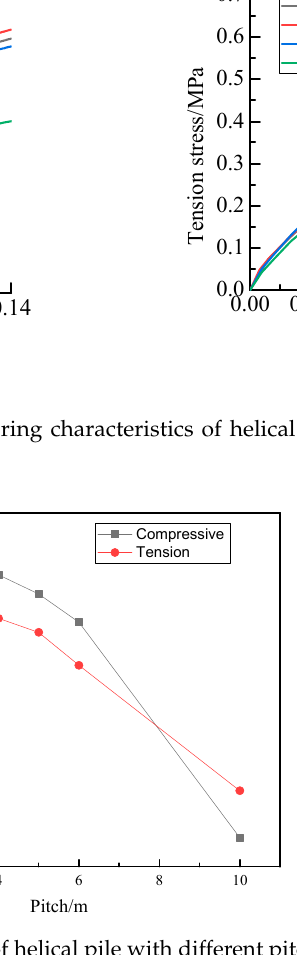
Figure 19. Uplift bearing characteristics of helical pile. ( a ) Load-displacement curves; ( b ) V/S -dis- placement curves.